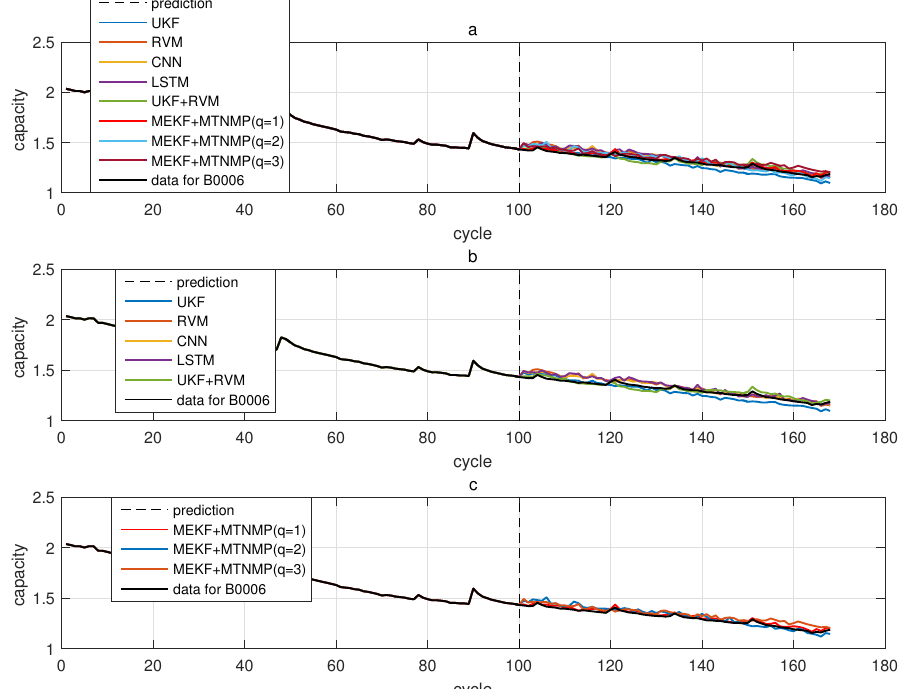
Figure 10. The simulation diagram of B0006 predicted from the 100th time. ( a ) is the experimental diagram of all methods, ( b ) is other methods used for comparison in ( a , c ) is the method proposed in this paper in ( a